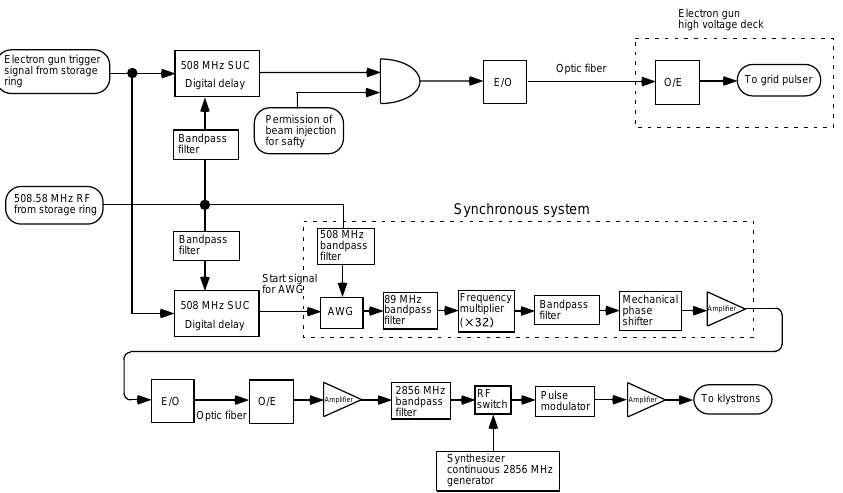
FIG. 3. Test scheme of the new synchronization method for electron beam operation. E (cid:1) O and O (cid:1) E are an electric-to-optic converter and an optic-to-electric converter, respectively. An electron gun trigger signal and 508.58 MHz rf generated in the storage ring are sent to the linac control room through phase-stabilized optic fibers. To compare the original continuous waveform of the 2856 MHz rf generated by a synthesizer with the 2856 MHz rf generated by the new method, an rf switch to select one of them is inserted before the pulse modulator. All apparatuses are synchronized with the 508.58 MHz rf for the storage ring.